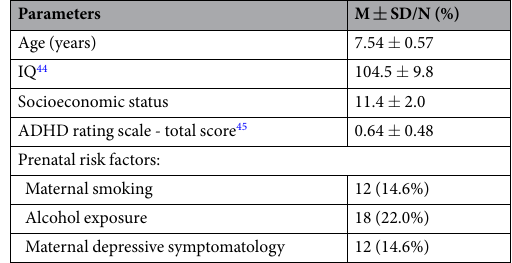
Table 3. Sample characteristics for the 82 boys selected from the FRANCES sample. The socioeconomic status (sum index) was calculated on the basis of maternal and paternal secondary education level and family income (theoretical range: 3–14; higher values indicating higher status). Presence of prenatal risk factors maternal smoking (self-report: cutoff: 1 cigarette/day), prenatal alcohol exposure (meconium ethyl glucuronide; cutoff: 10 ng/g) and prenatal maternal depressive symptomatology (Edinburgh Postnatal Depression Scale, EPDS 50 ; cutoff: 10) was not considered as an exclusion